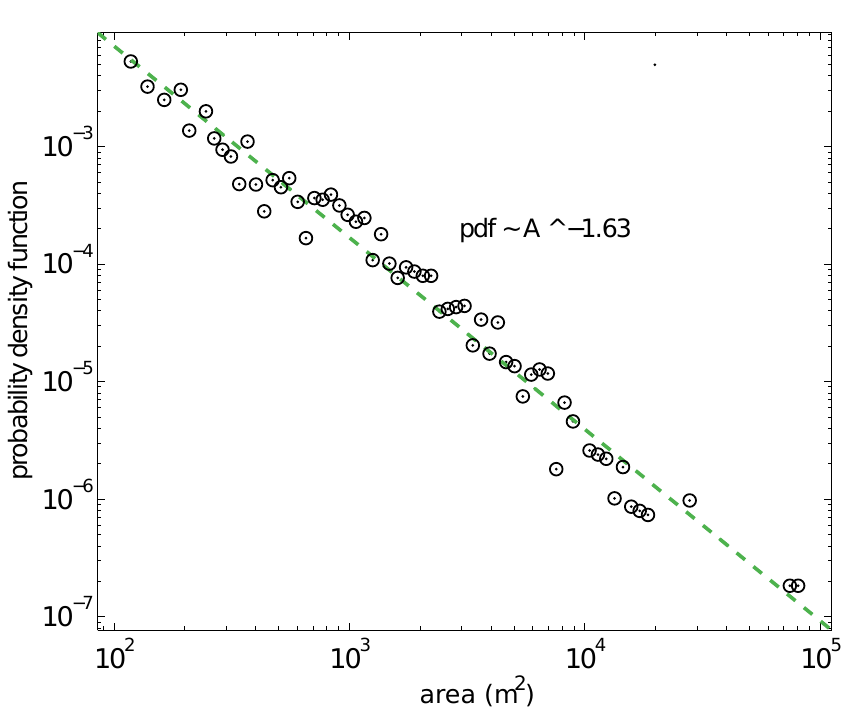
Figure 11. Probability density function (pdf) of landslide